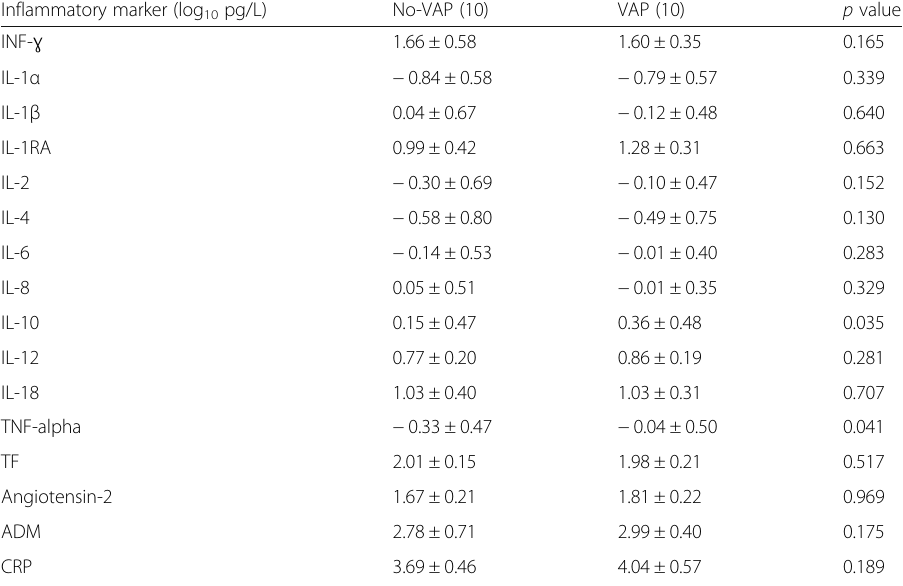
Table 5 Inflammatory markers between animals with or without VAP Inflammatory marker (log 10